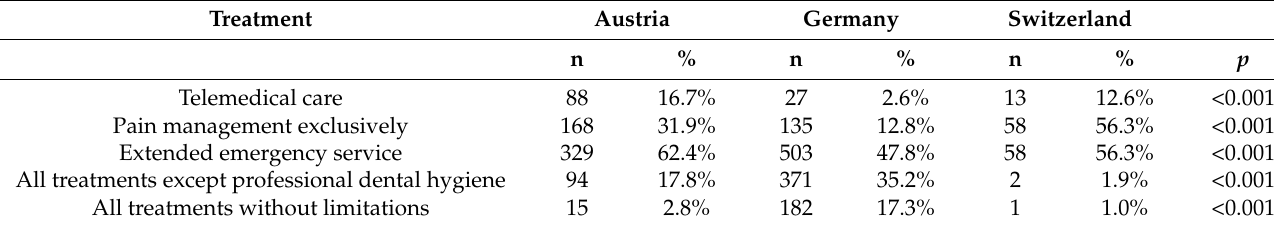
Table 1. Comparison of performed dental treatments during the first coronavirus disease 2019 (COVID-19) pandemic lockdown in Austria, Germany and Switzerland, multiple answers possible.